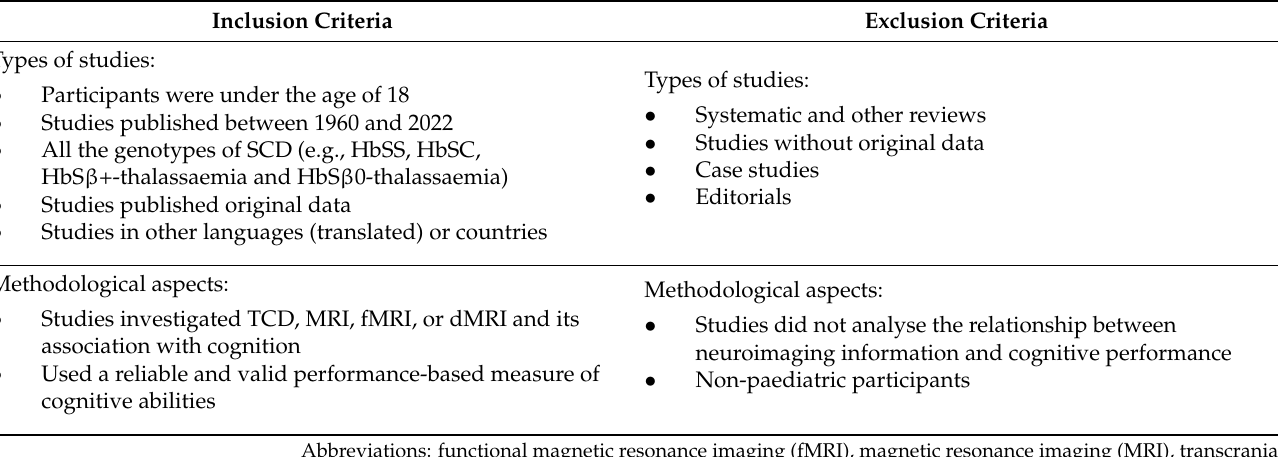
Table 2. Inclusion and exclusion